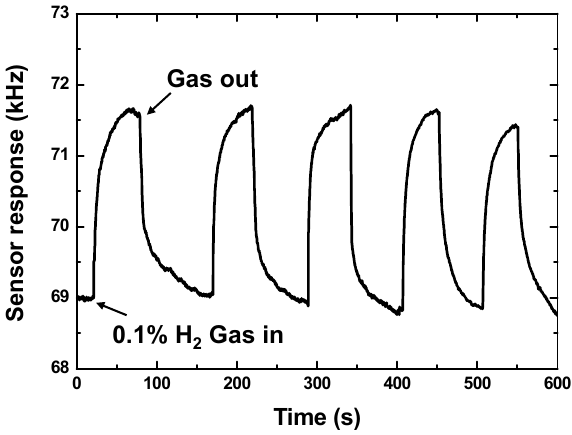
Figure 4. The repeatability measurement of the proposed sensing devices coated with 10 nm Pd-Ni alloy thin-film.